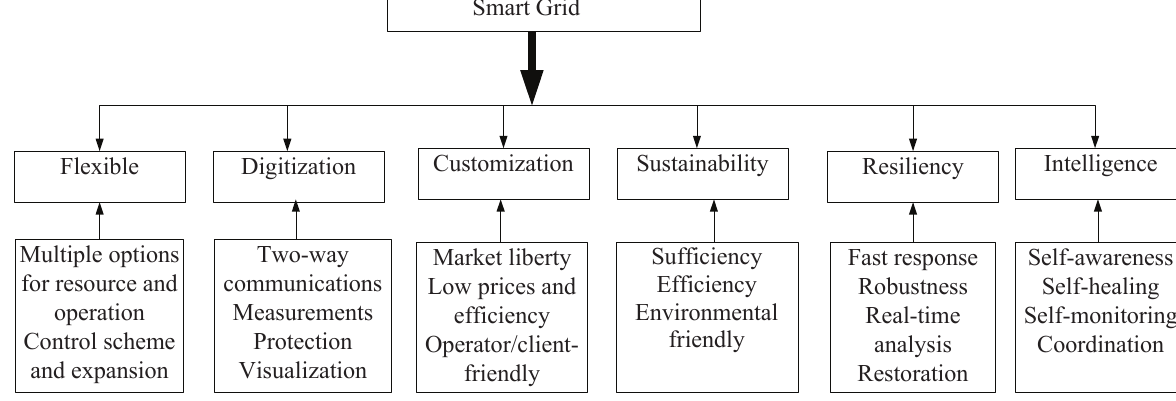
Figure 1. The main characteristics of a smart